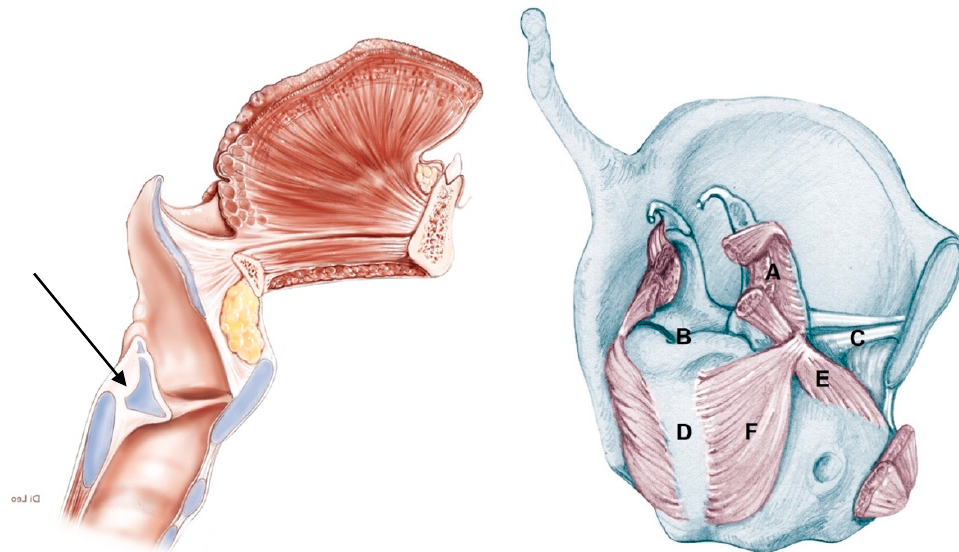
Figure 1. General view of the larynx in the sagittal plane ( left ) and a particular view of the crico-arytenoid unit (CAU) ( right )—Mean percentages of neoplastic involvement of the CAU’s components in the case of arytenoid fixation: (A) Inter-arytenoid muscle: 57.8%; (B) Crico-arytenoid joint: 40.1%; (C) Thyro-arytenoid muscle: 71.8%; (D) Cricoid plate: 73.3%; (E) Lateral crico-arytenoid muscle: 73.3%; (F) Posterior crico-arytenoid muscle: 30.0%.